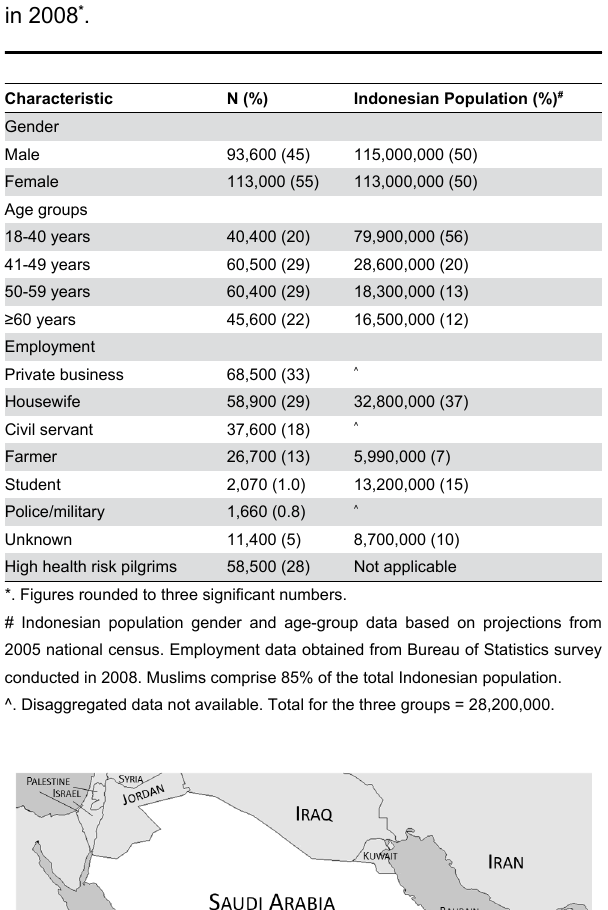
Table 1. Demographic characteristics of Indonesian population in 2008 and Indonesian pilgrims during the Hajj in 2008 * .